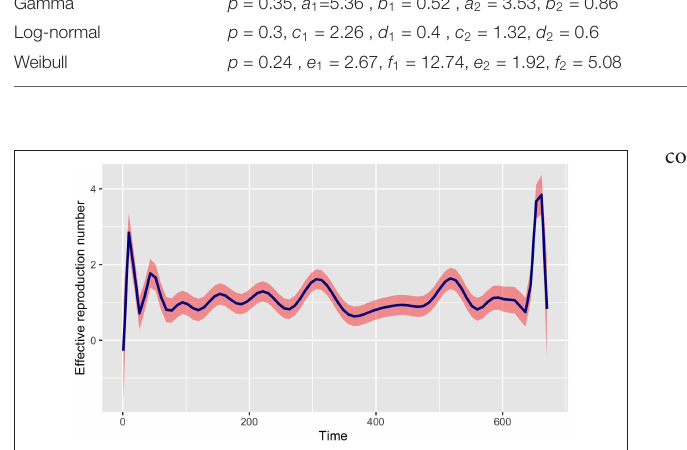
FIGURE 5 | Evolution of the time varying reproductive number in Mayotte from 13 March 2020 to 11 January 2022 with the best-fit mixture of the SI.